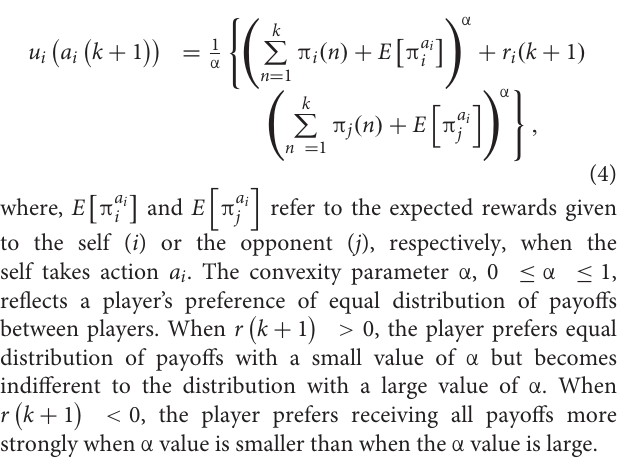
TABLE 1 | The reward scale of the chicken game employed in the present study. Player 1